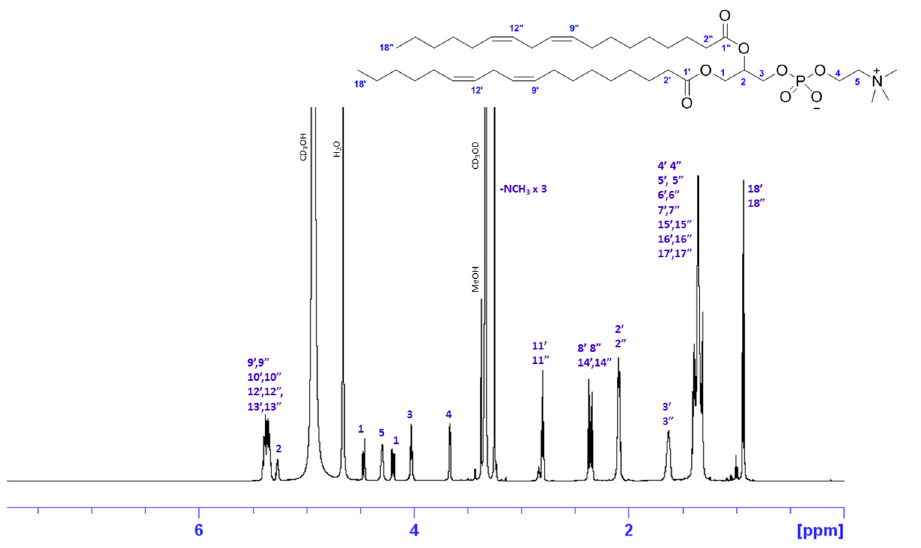
Figure 4. 1 H NMR spectrum of major PC 1,2-dilinoleoylphosphatidylcholine measured in CD 3 OD